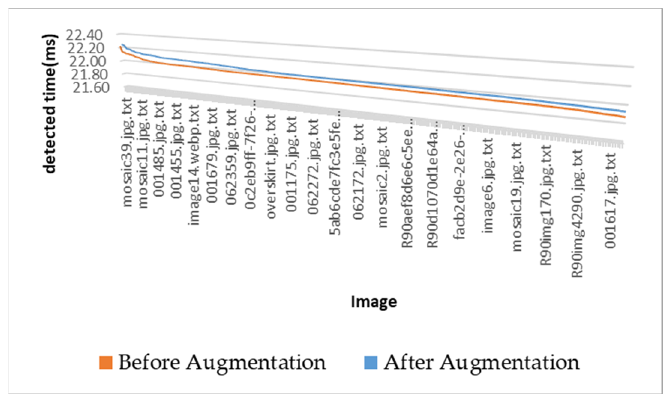
Figure 14. Detection time comparison for Before and After Augmentation.